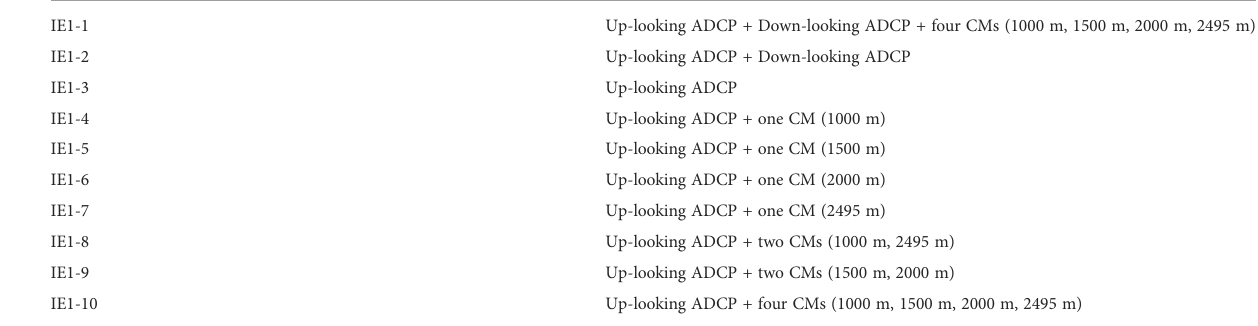
TABLE 2 Details of the IEs at the mooring